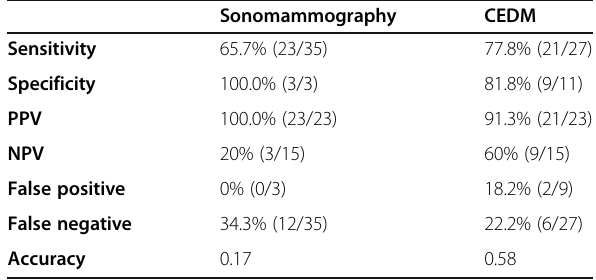
Table 3 Sonomammography vs. CEDM